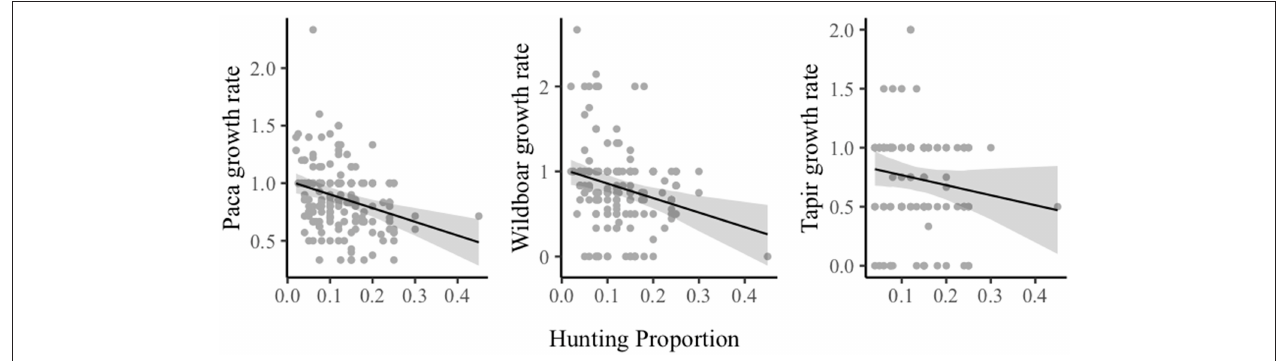
FIGURE 10 | Impact of hunting on the animal population.